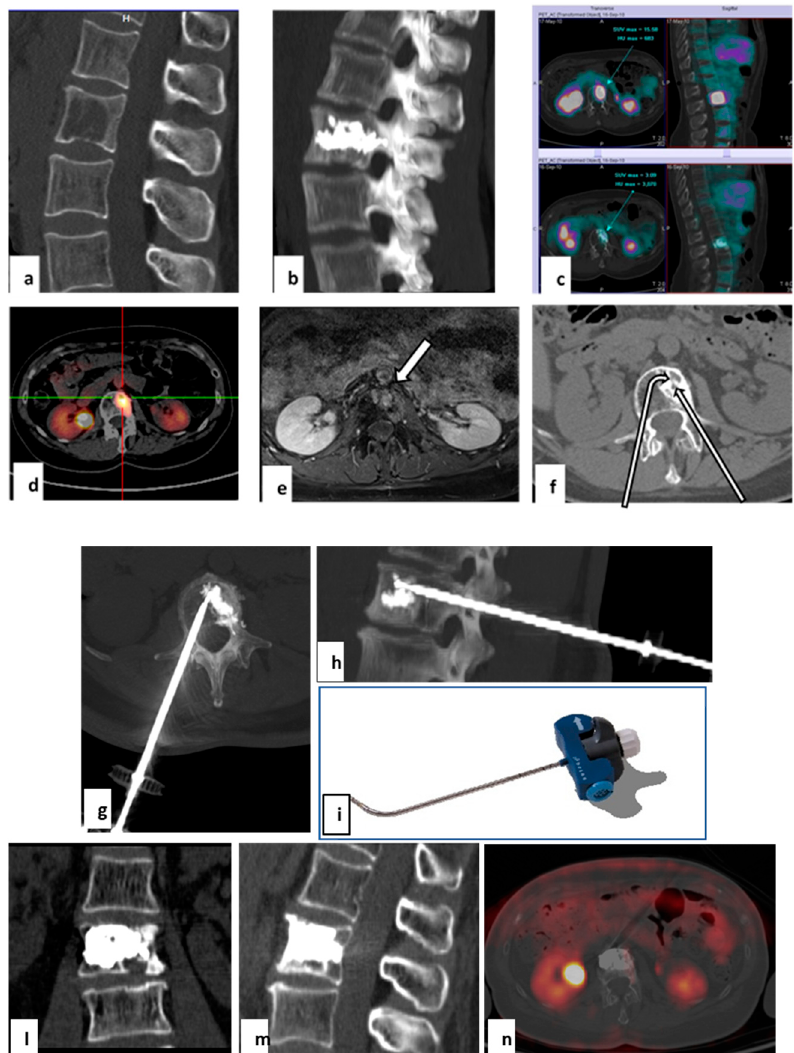
Figure 4. Treatment with tRFA and VA of a recurrent metastasis in a 57-year-old woman with a single L2 lytic metastasis from breast cancer. The metastasis had been treated previously with microwave ablation. Sagittal CT reconstruction showed a large lytic metastasis of L2 treated with microwave ablation ( a ). Sagittal CT obtained with MIP technique demonstrated the results of vertebral augmentation ( b ). PET-FDG performed before and 4 months after treatment demonstrates complete absence of metastasis uptake ( c ). Vertebral tumor recurrence 12 months after the microwave ablation treatment. FDG-PET demonstrated intense uptake of the vertebral body, anterior to the cemented area ( d ). T1 MRI with fat suppression acquired after gadolinium infusion revealed an area of contrast enhancement related to recurrence ( e ). Cement interposition hindered access to metastasis by left transpeduncular route with straight needle (straight arrow). The lesion can be reached by contralateral transpeduncular approach with a steerable needle (tSTAR) ( f ). Axial and coronal CT scans reconstructed with MIP technique ( g , h ) after tRFA navigation system placement ( i ). Coronal and sagittal CT scans after treatment of the second vertebroplasty ( l , m ). PET-FDG performed after 6 months demonstrates absence of metastasis uptake ( n